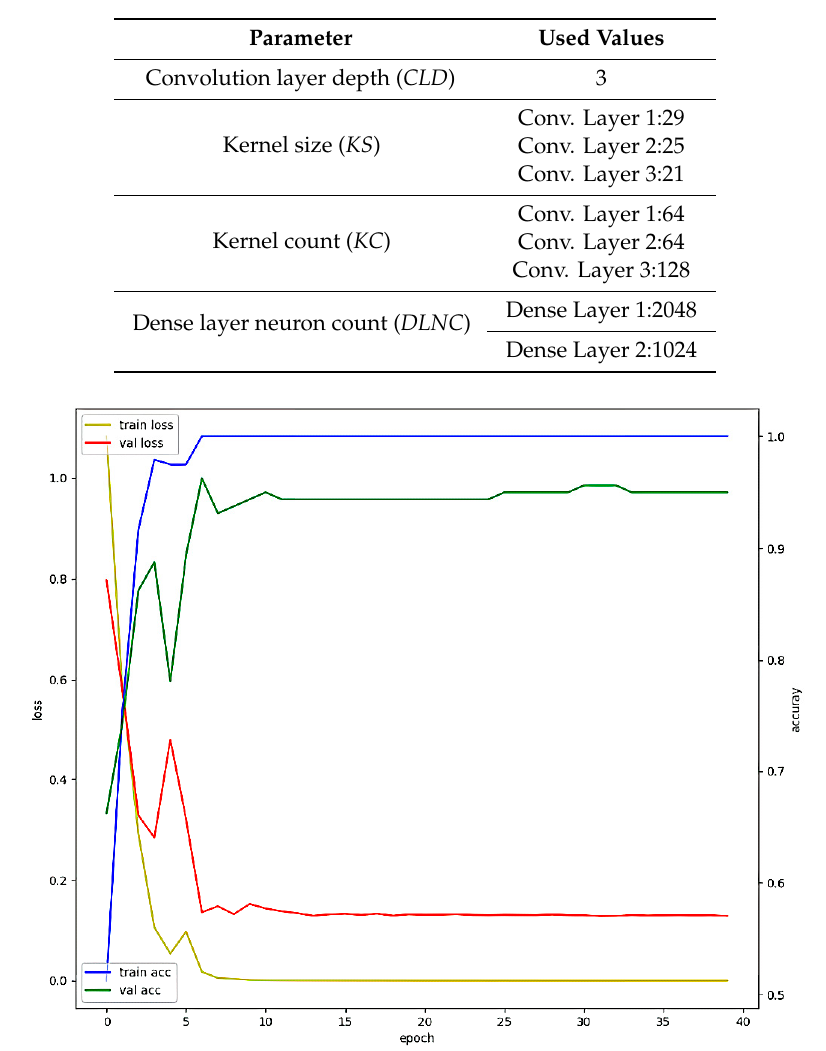
Table 8. To evaluate the performance of the proposed 1-D CNN model, each parameter value is selected from the optimal parameter range.